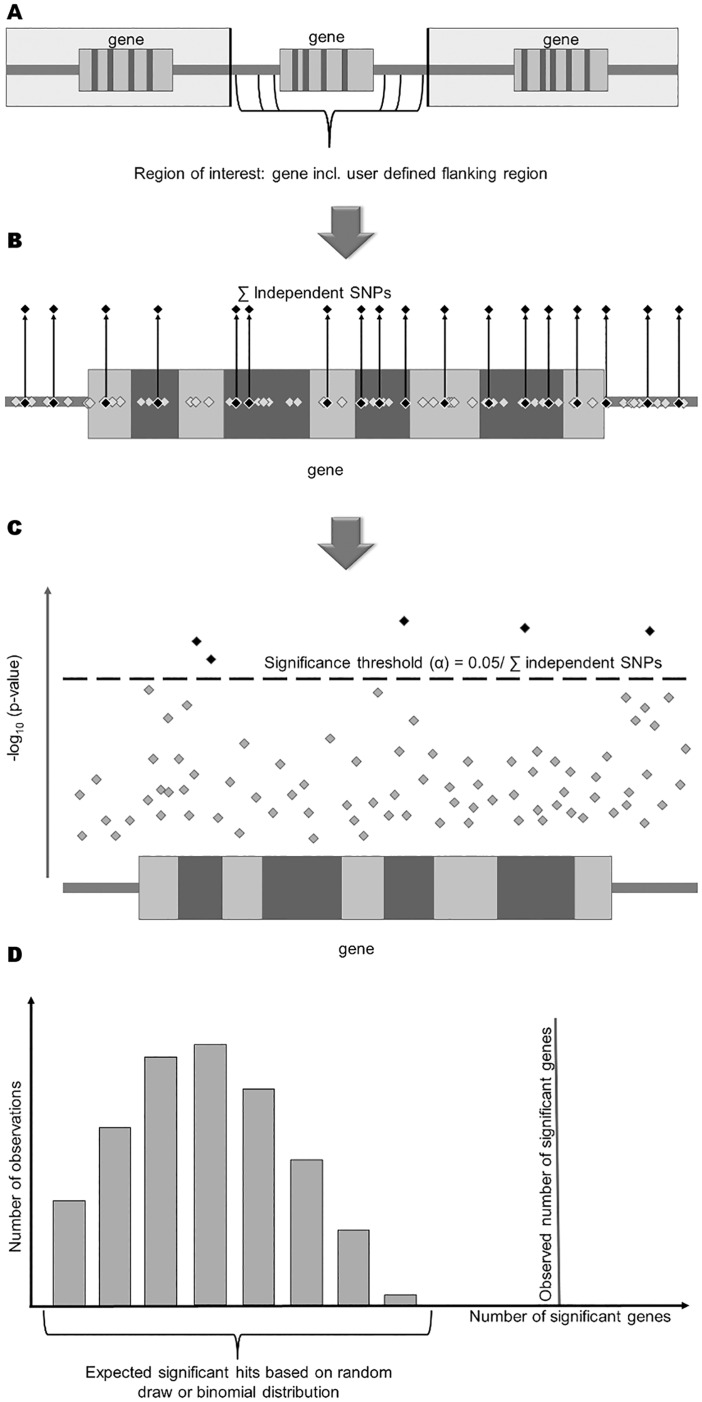
GenToS principle.(A) First, GenToS extracts for each gene on a given candidate gene input list the region of the gene including a user-defined flanking region. (B) Next, all independent SNPs within each region are identified from a reference population, and a significance threshold based on the number of independent SNPs is calculated. (C) In the final step, SNPs with an association p-value below the calculated significance threshold are extracted from the human GWAS summary results. (D) Enrichment of the number of observed significant genes (vertical line) can be assessed visually compared to the expected number based on a null distribution derived by resampling from a binomial distribution (histogram).